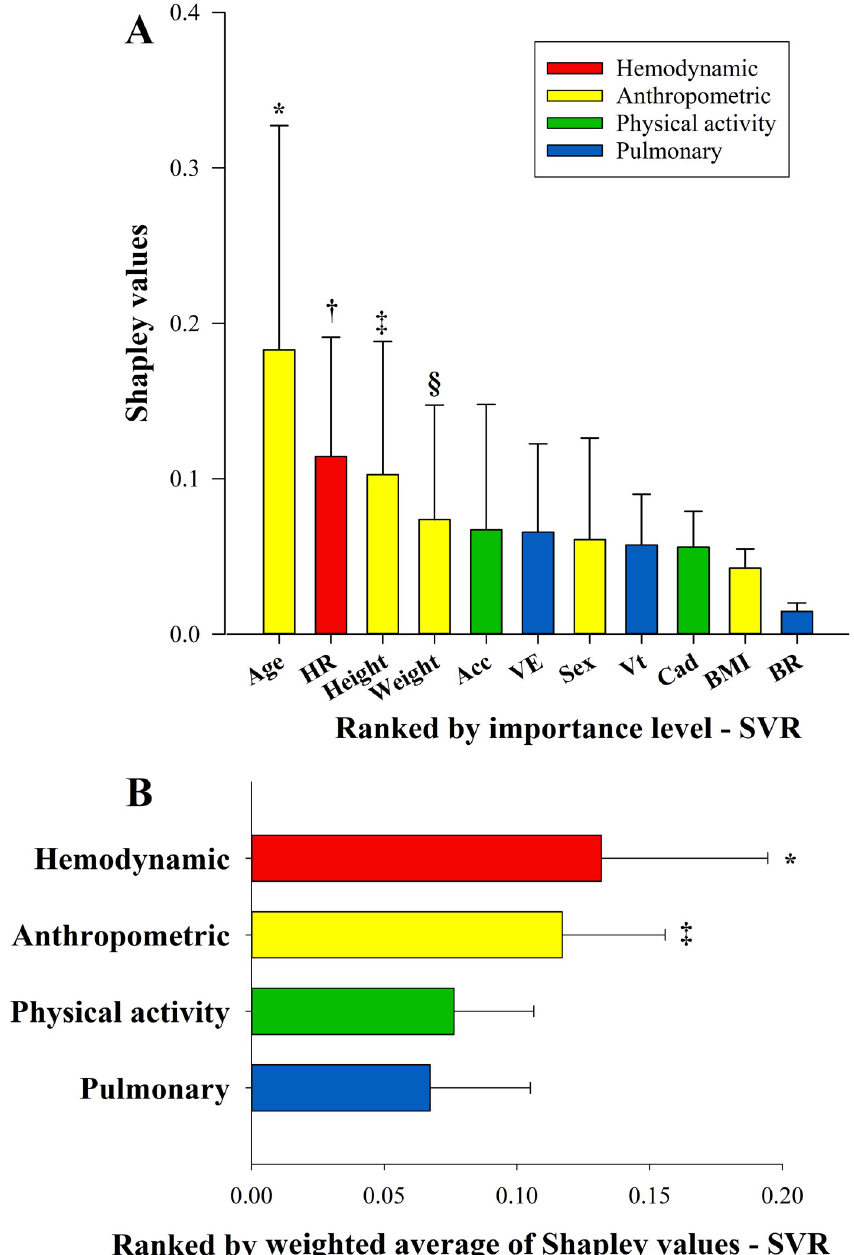
Fig 5. Shapley values (importance level) of the inputs used to predict cardiovascular fitness. A- Median and 25- 75th percentile of Shapley values of the inputs from the Support Vector Regression (SVR). � Significant difference between age and BR (p > 0.001), between age and BMI (p > 0.001), between age and Cad (p = 0.006). † Significant difference between HR and BR (p = 0.003). ‡ Significant difference between height and BR (p = 0.004). § Significant difference between Weight and BR (p = 0.049). B- Mean ± SD of Weighted average of Shapley values of the domains from the Support Vector Regression (SVR) model. � Significant difference between Hemodynamic and Physical Activity (p = 0.010), between Hemodynamic and Pulmonary (p = 0.003). ‡ Significant difference between Anthropometric and Pulmonary (p = 0.023). HR: heart rate, Acc: total hip acceleration; BMI: body mass index; BR: breathing rate, Vt: tidal volume; Cad: walking cadence, Ve: minute ventilation.